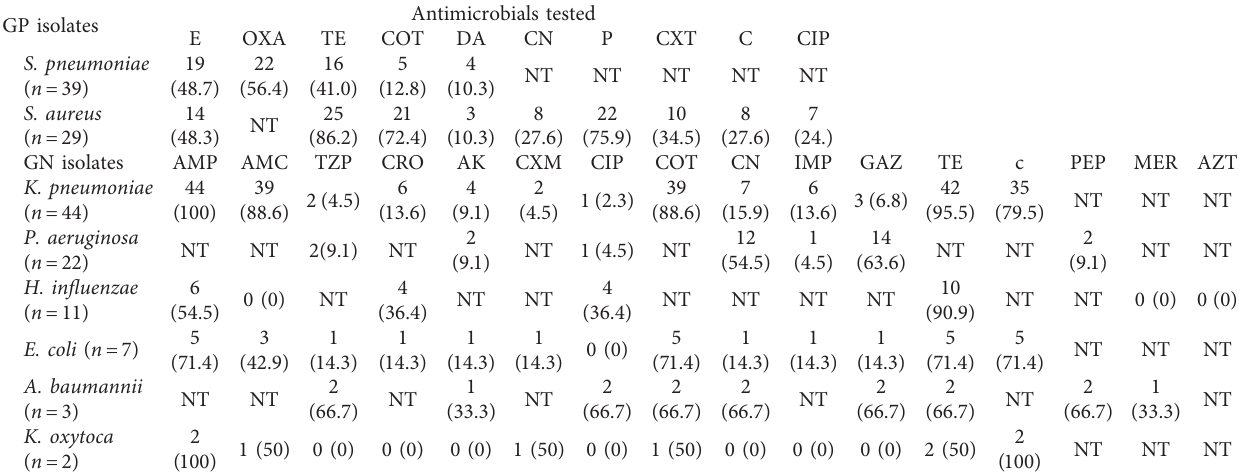
Table 3: Antimicrobial resistance profile of bacterial isolates, Dessie, 2020.